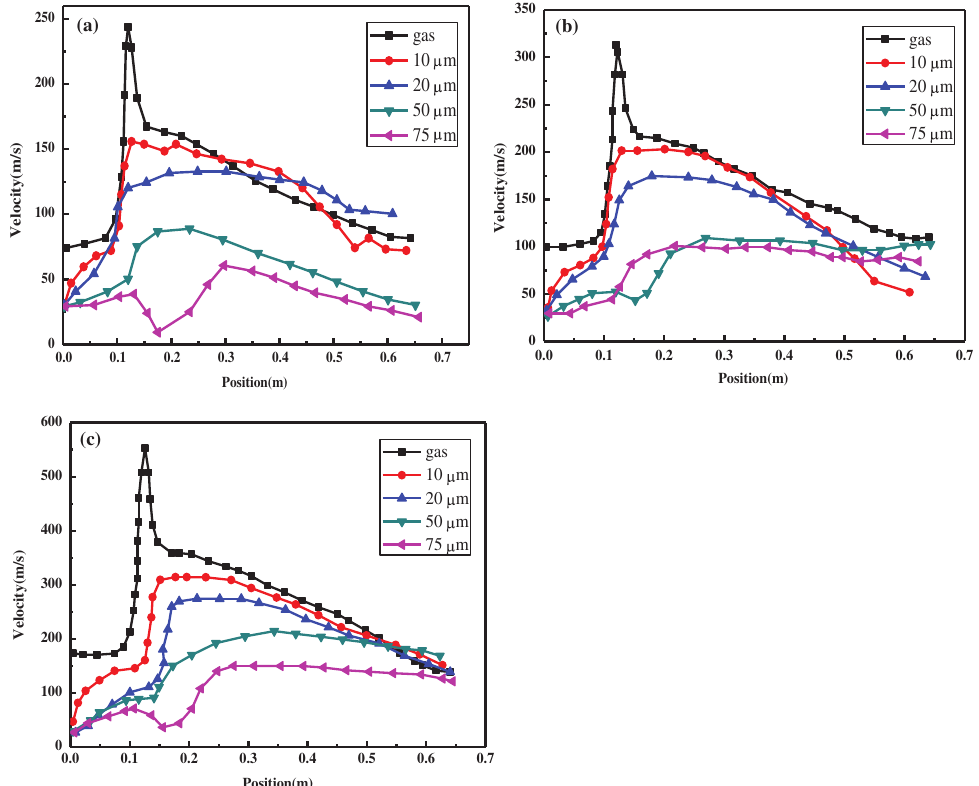
Figure 9: Gas velocity versus to particle velocity for different size particles at different Mach numbers: (a) Mach 0.3, (b) Mach 0.5 and (c) Mach 0.9.